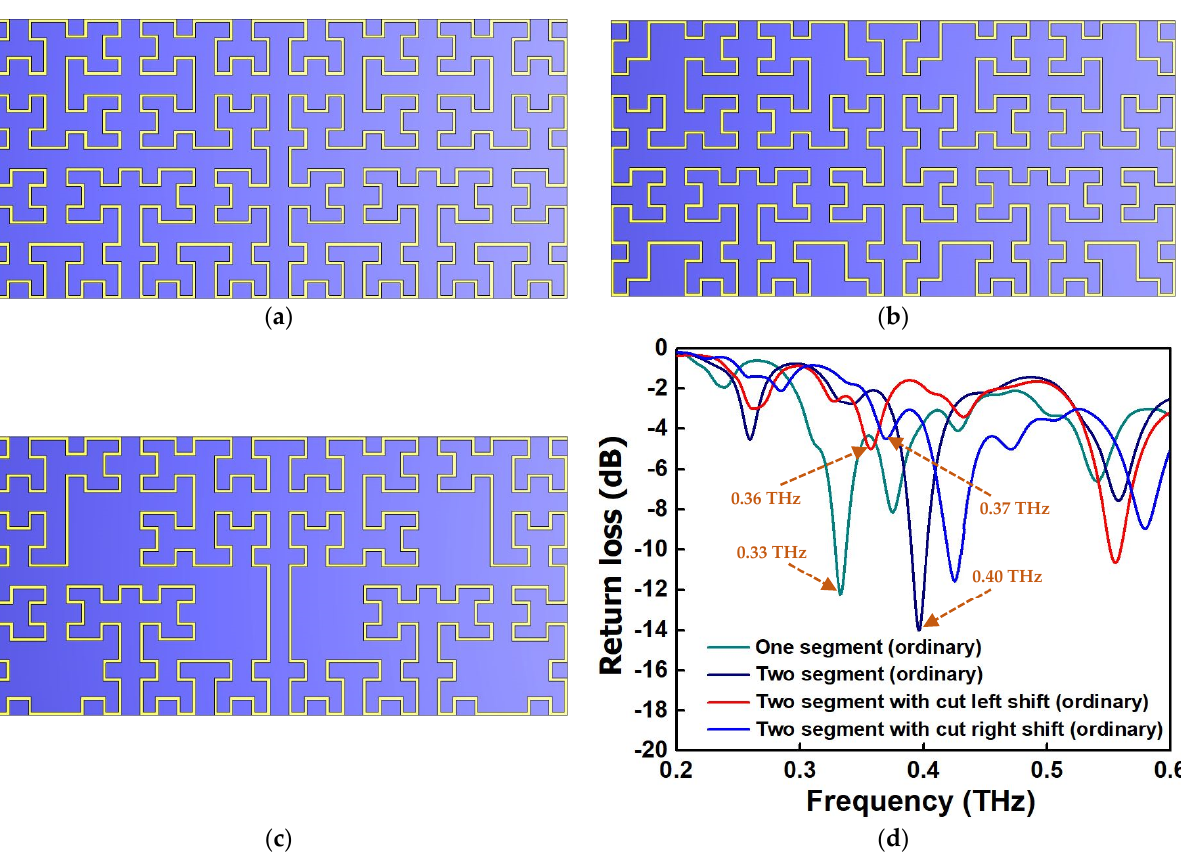
Figure 4. Reconfigurable Hilbert fractal antenna: ( a ) two segments without cut arm, ( b ) two segments with longer electrical length, ( c ) two segments with shorter electrical length and ( d ) large frequency shift by disconnecting or removing some part of the fractal pattern or electrical length. Here, we observe a left ward shift in frequency when the size of the fractal pattern is reducing and when size is increasing, we observe a rightward shift in frequency. This is clearly shown by the switching between one segment and two segment fractal design. Medium range frequency shift can be achieved by removing a smaller portion of the fractal pattern in the design. Here, three arms are cut from each segment, which means that the electrical length increases. A ~0.02 THz downward shifted is observed (leftward shift). With even larger cut and arm length reduction, a rightward frequency shift is observed. Both techniques can be easily implemented by embedding diode-based switches at the junctions in the antenna to turn certain parts of the antenna on and off